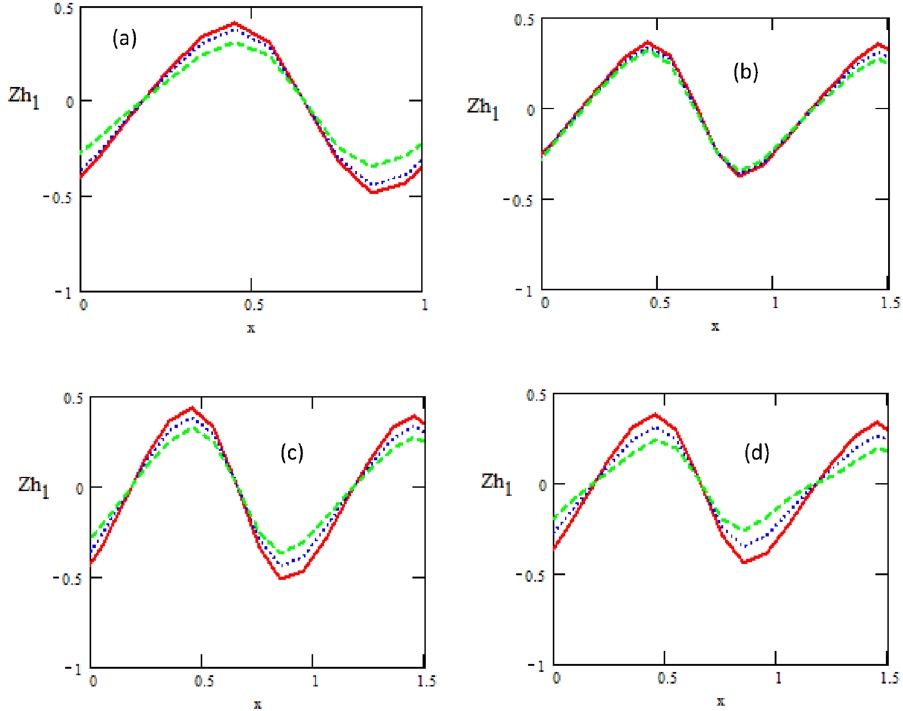
Figure 5. Variations of the heat transfer coefficient concerning the axial-x with different values of 0.1_, 0.3. .., 0.5 ( a ) N = 1 _, 2. .., 3 ( d ) Pr =